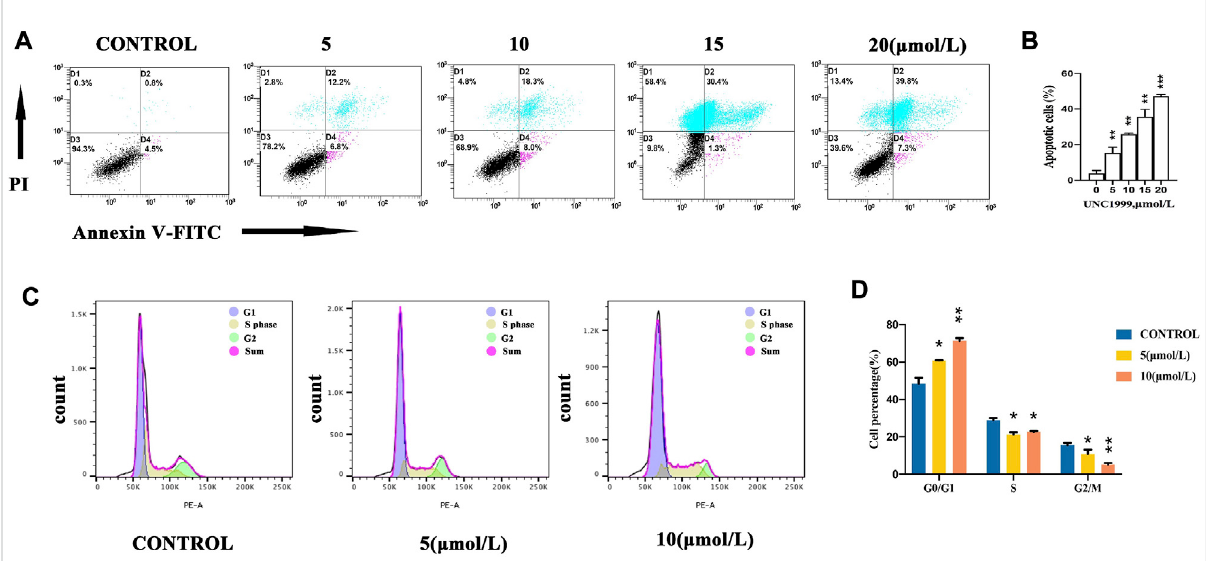
UNC1999 gives rise to apoptosis in uveal melanoma cells. (A,B) OMM1 cells were treated with 5, 10, 15, and 20 μ M for fl ow cytometric analysis. (C,D) OMM1 cells were blocked at the S phase in both the 5 and 10 μ M groups in the cell cycle. Data are expressed as mean ± SD from at least